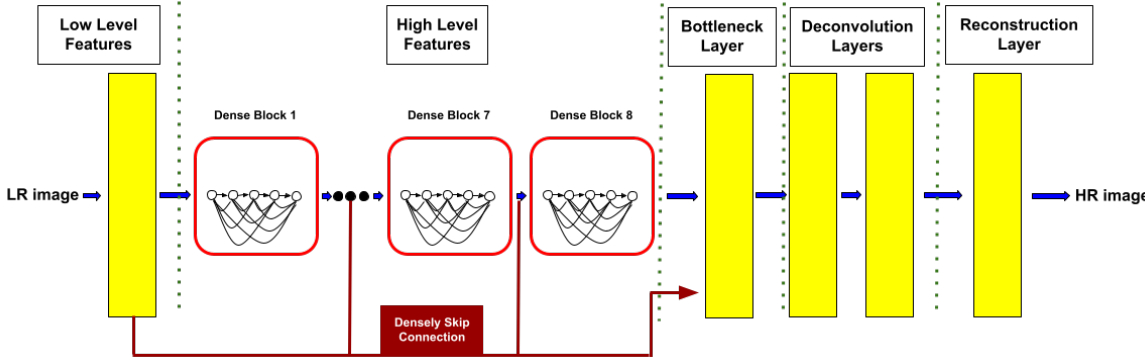
Figure 2. SRDensenet—all architecture with eight